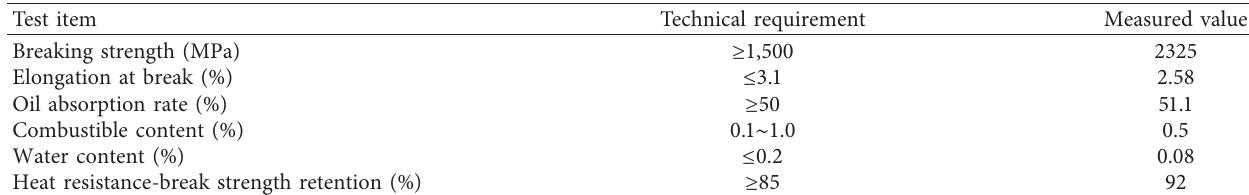
Table 4: Performance indices and test results of basalt